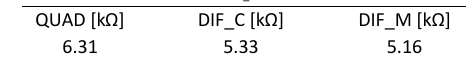
Table 2: Measured values of Z